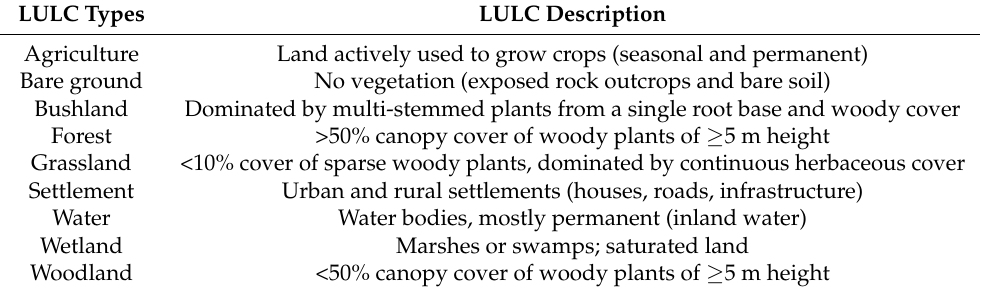
Table A2. Description of Land use/Land cover (LULC) classes used in our analysis modified from a classification system by [32,33] in the Enduimet Wildlife Management Area, Tanzania, from